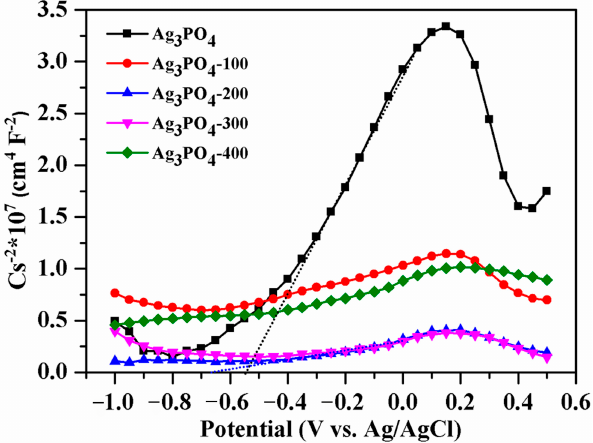
Figure 11. Mott-Schottky (MS) plots of the electrodes prepared by pristine and calcined Ag 3 PO 4 samples.